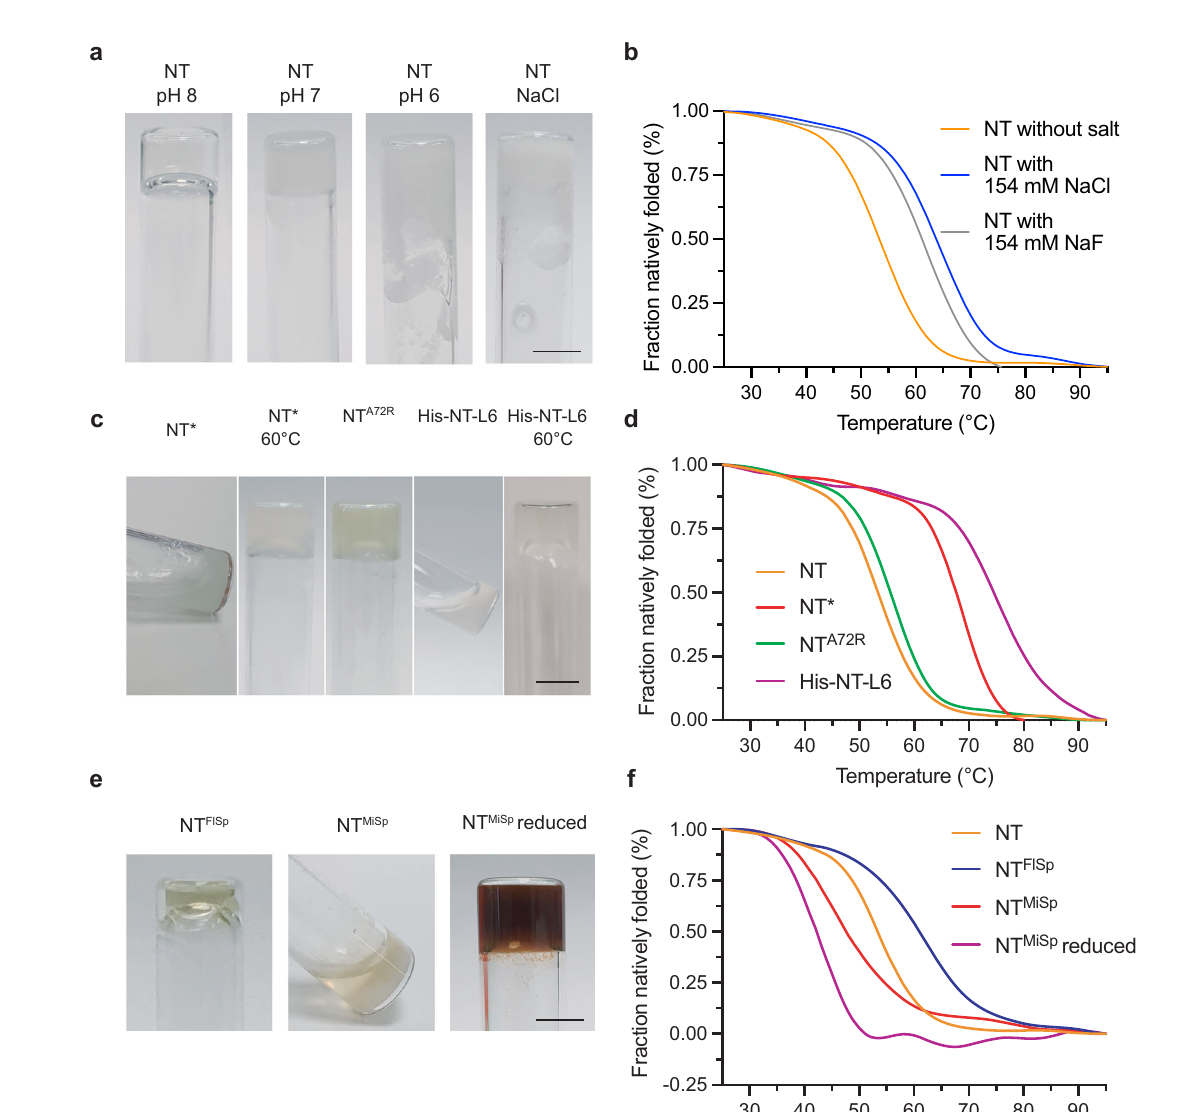
Fig. 4 | NMRspectroscopy ofHis-NT2RepCT and NT and fi brillationpropensity pro fi le of NT. a 2D 15 N-HSQC spectra of a 10mg/ml His-NT2RepCT solution before (blue) and after (red) incubation at 37°C for 19h. Isolated cross-peaks in the red spectrum and F24, G136, polyA in the blue spectrum are assigned using one-letter amino acid symbols and residue numbers. The inset shows signal intensity versus time for selected residues from the NT, 2Rep and CT domains. b Solid-state radio- frequency driven recoupling (RFDR) spectra of His-NT2RepCT hydrogels. C α /C β correlationsofresiduesobservedintheRFDRspectrumdeterminedbycomparison with the chemical shifts of model peptides and values obtained from statistical data 82,83 and theirsecondary structureareindicated.SSB – spinning side band. c 1D 15 N-HSQCspectraofa10mg/mlNTsolutionduringincubationat37°Cfor36h.The inset shows bulkintensity versus time. d Solid-state RFDR spectraof NT hydrogels. C α /C β correlations of the residues observed in the RFDR spectrum and their